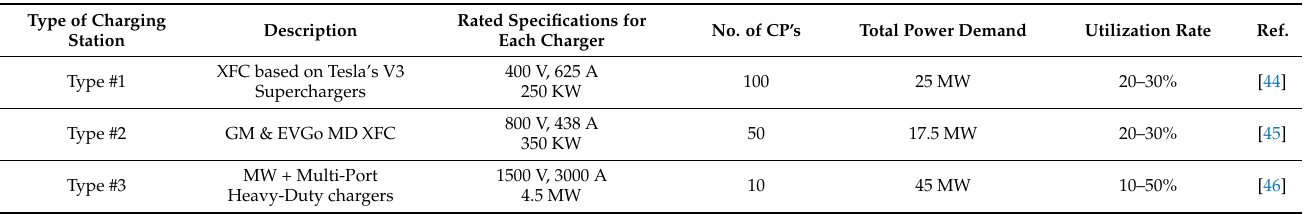
Table 2. Specifications of different types of XFC charging stations considered in the system